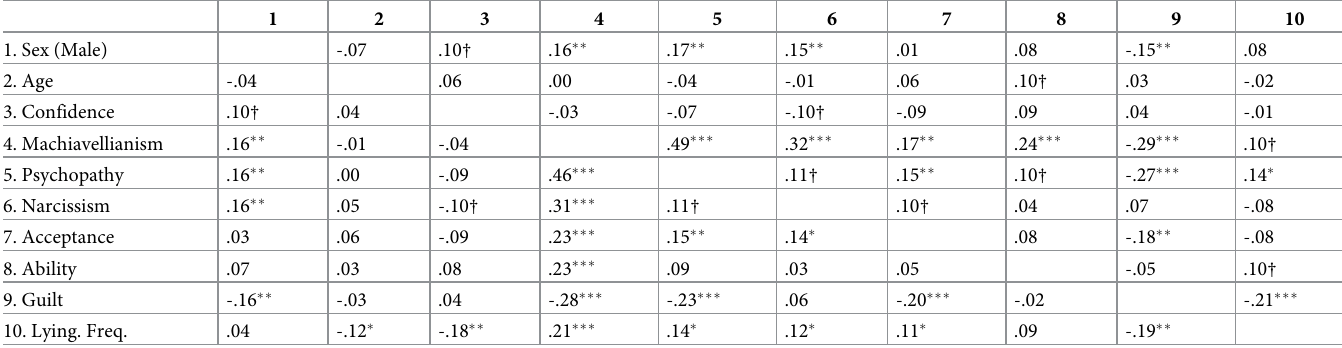
Table 1. Zero-order correlation between the